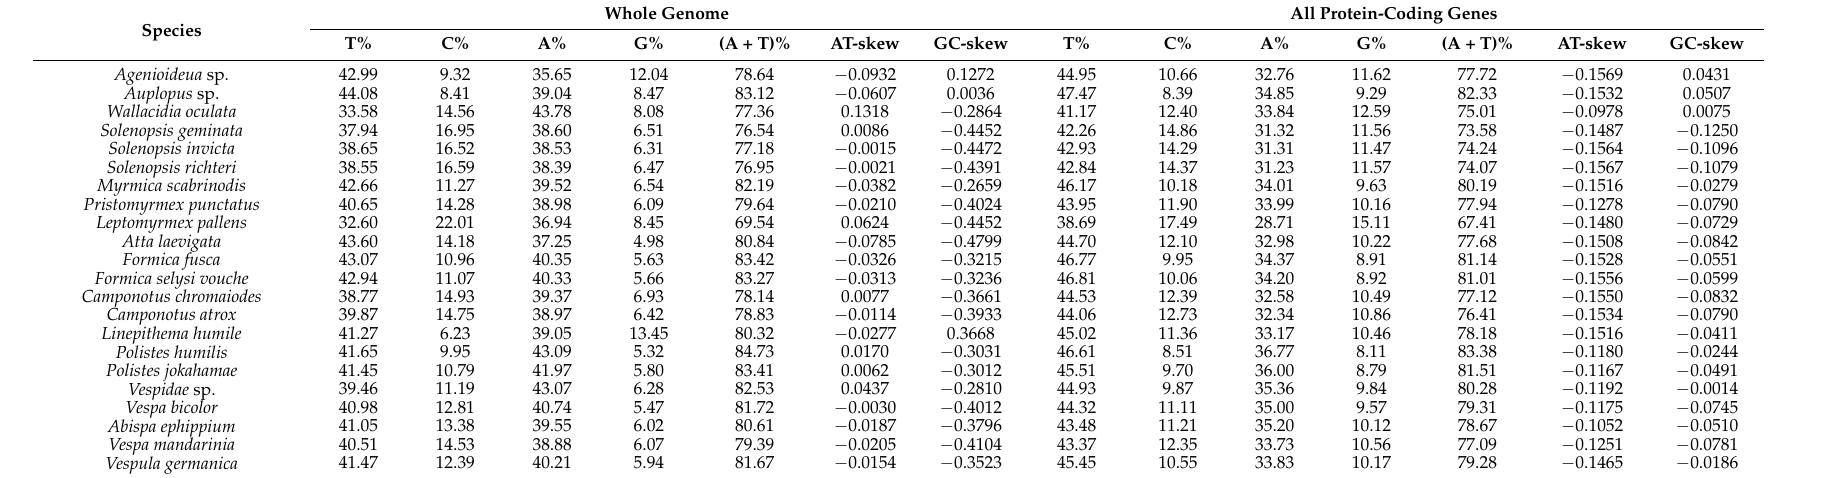
Table 1. Base composition of the mitochondrial genomes in